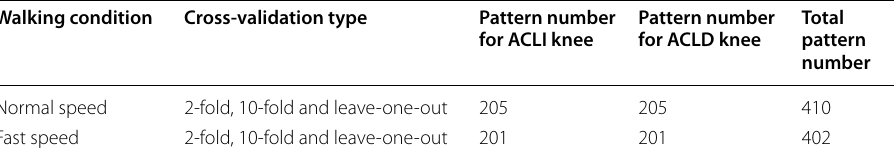
Table 4 Experiments for gait patterns classification between ACLI and ACL-D knees under different walking conditions Walking